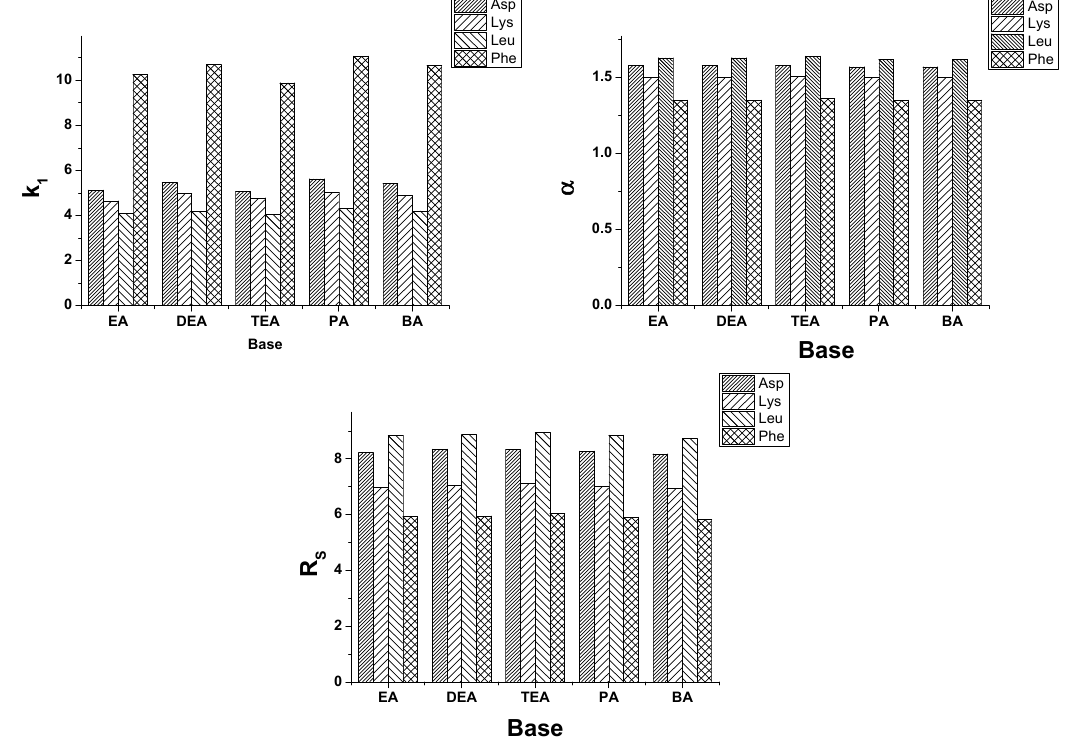
Figure 7. Effects of the natures of base additives on the chromatographic parameters of k 1 , α and R S of Fmoc-Asp(O t Bu)-OH, Fmoc-Lys(Boc)-OH, Fmoc-Leu-OH and Fmoc-Phe-OH. Chromatographic conditions: columns, QN-AX™; mobile phase, CO 2 /MeOH (60/40 v/v ) containing 30 mM base and 60 mM FA; flow rate, 2.0 mL min − 1 ; T col , 40 ° C; back pressure, 150 bar; detection, 262 nm. Symbols: for Asp(O t Bu)-OH; for Fmoc-Lys(Boc)-OH; for Fmoc-Leu-OH; and Fmoc-Phe-OH.